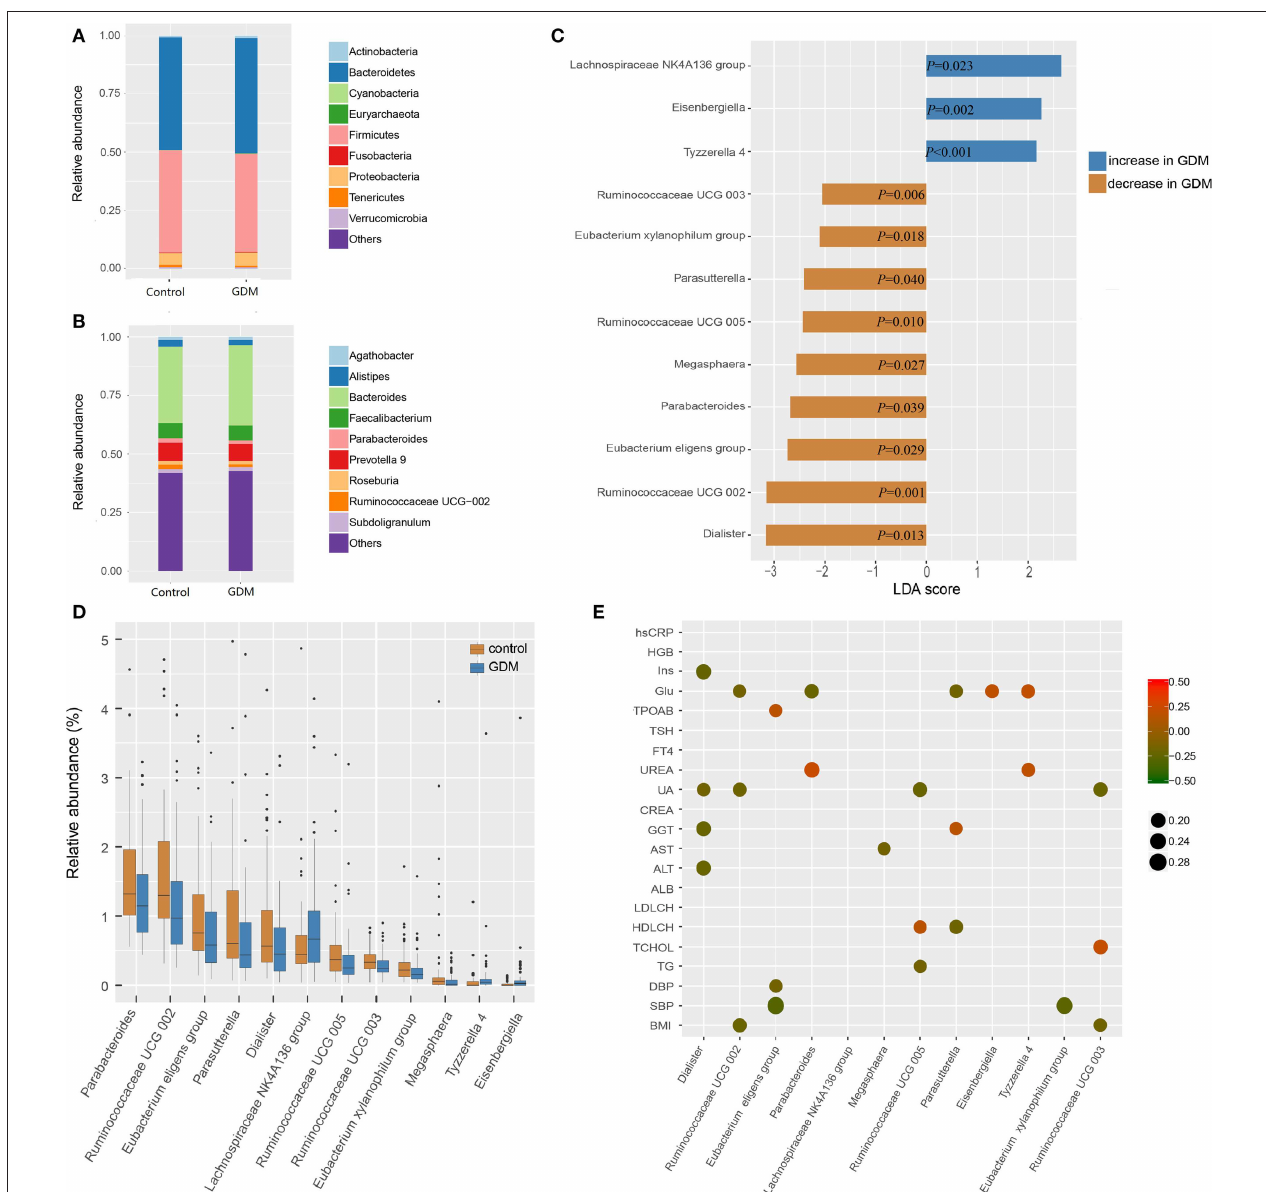
FIGURE 2 | Different bacterial taxa between healthy control and GDM groups. (A) Relative abundance of the top 10 bacterial taxa at the level of bacterial phylum. (B) Relative abundance of the top 10 bacterial taxa at the level of bacterial genus. (C) Linear discriminant analysis (LDA) score of differential taxa at genus level based on LEfSe ( P < 0.05 and LDA threshold value > 2). The abscissa is the LDA value, the GDM-enriched genera are shown as blue bars, the control-enriched genera are shown as orange bars, and the P -value is shown in each bar. (D) Boxplot of differential taxa at genus level. (E) Spearman’s rank correlation heatmap of differential taxa at genus level and clinical indices. Circles that tend to red and tend to green represent positive and negative correlations, respectively.